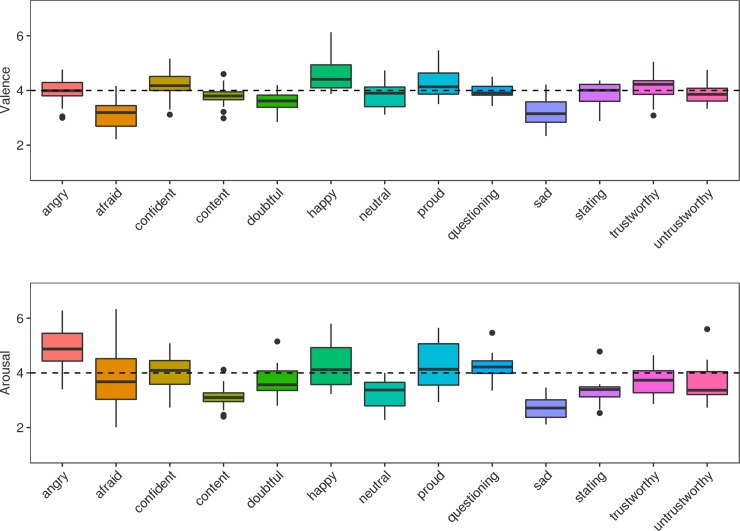
Box and whisker plots illustrating perceived valence (top) and perceived arousal (bottom) for each expression for a by-item analysis that used data points for each speaker and expression averaged across listeners and sentences. Black dashed lines indicate the rating scale midpoint.